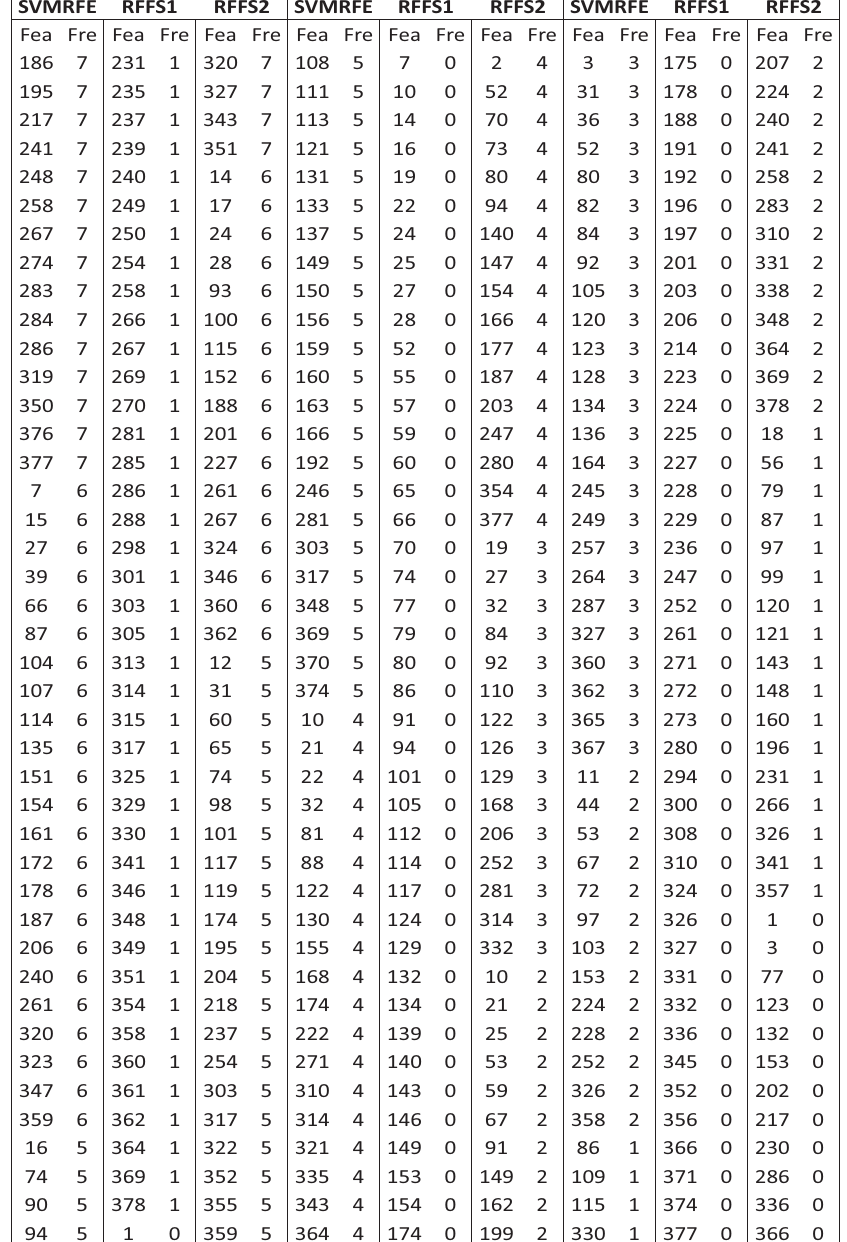
Figure A7. SVMRFE and RFFS results of FNC data, Part